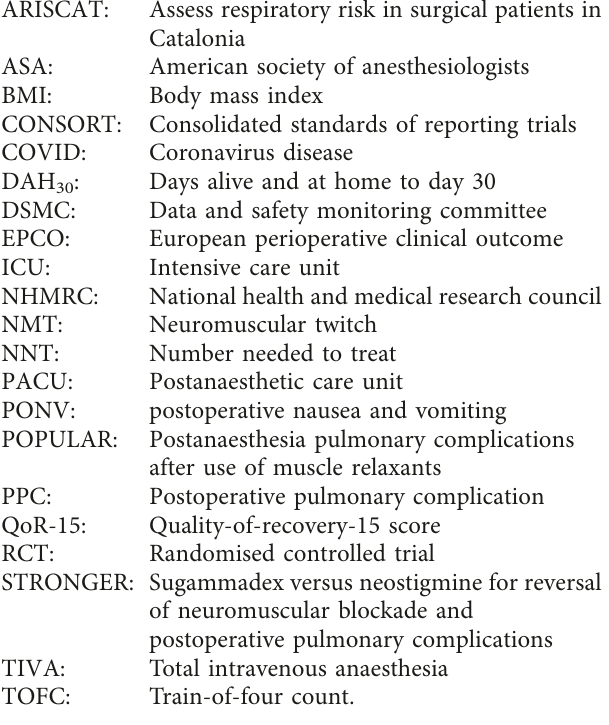
Protocol 2.1 – Full Protocol of trial. CONSORT